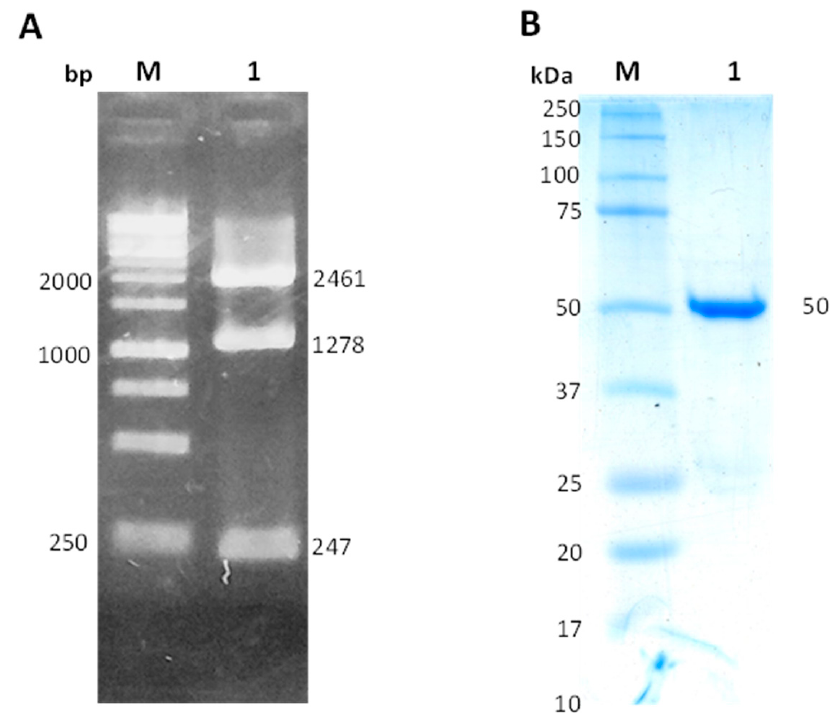
Figure 2. Construction of the vector pET3aHisTEVP-zwf and purification of the recombinant HpG6PD protein: ( A ) Analysis of the digestion with NdeI and BamHI enzymes in 1% agarose gel electrophoresis. M: GeneRuler 1 Kb Plus DNA molecular weight marker (Thermo Scientific ® , Hudson, NH, USA). Line 1 Plasmid Puc57 digested with NdeI and BamHI enzymes; ( B ) Purification of the recombinant HpG6PD protein. M: molecular protein weight (MW) marker precision plus protein kaleidoscope standards from Bio-Rad (Hercules, CA, USA). Line 1: 20 micrograms of purified HpG6PD protein. The gels are representative of three independent experiments.